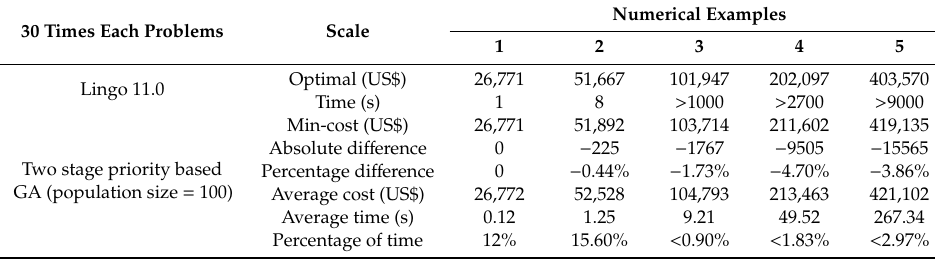
Table 13. Comparison with Lingo in Experiment